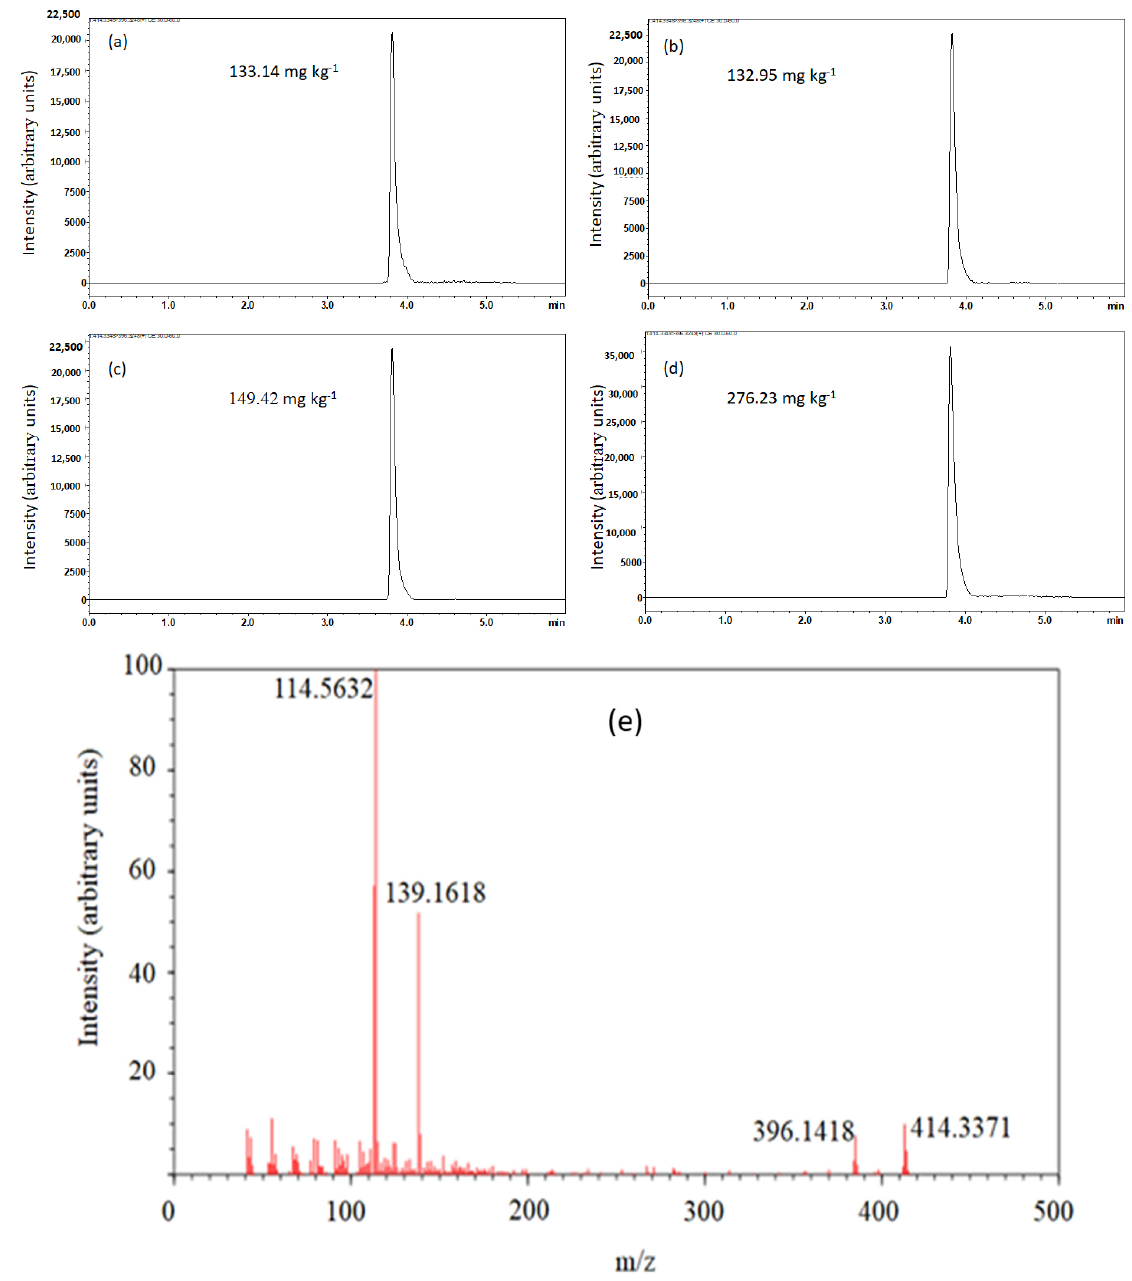
Figure 6. Chromatogram of the lowest extracted concentration of solasodine in ( a ) NaCl and ( b ) Na 2 CO 3 , and highest extracted concentration of solasodine ( c ) NaCl and ( d ) Na 2 CO 3 for running 1. ( e ) mass spec of